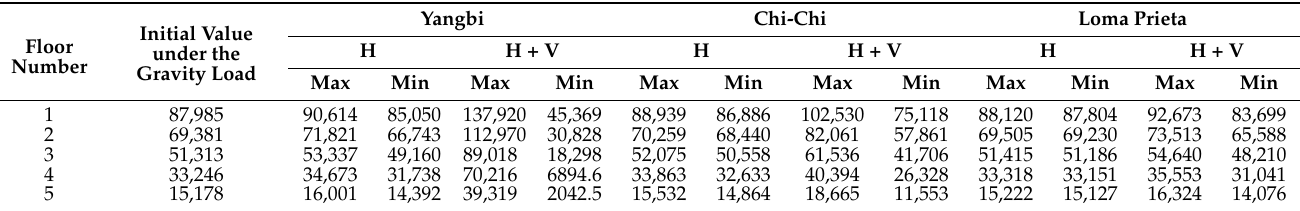
Table 5. Maximum and minimum axial force of columns bottom of each layer/kN.